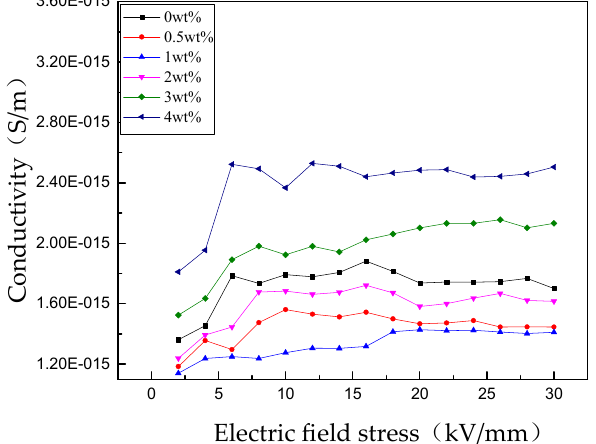
Figure 9. Versus E curves of RIP with different nano-SiO 2 nanoparticle Figure 9. versus E curves of RIP with different nano-SiO 2 nanoparticle components.